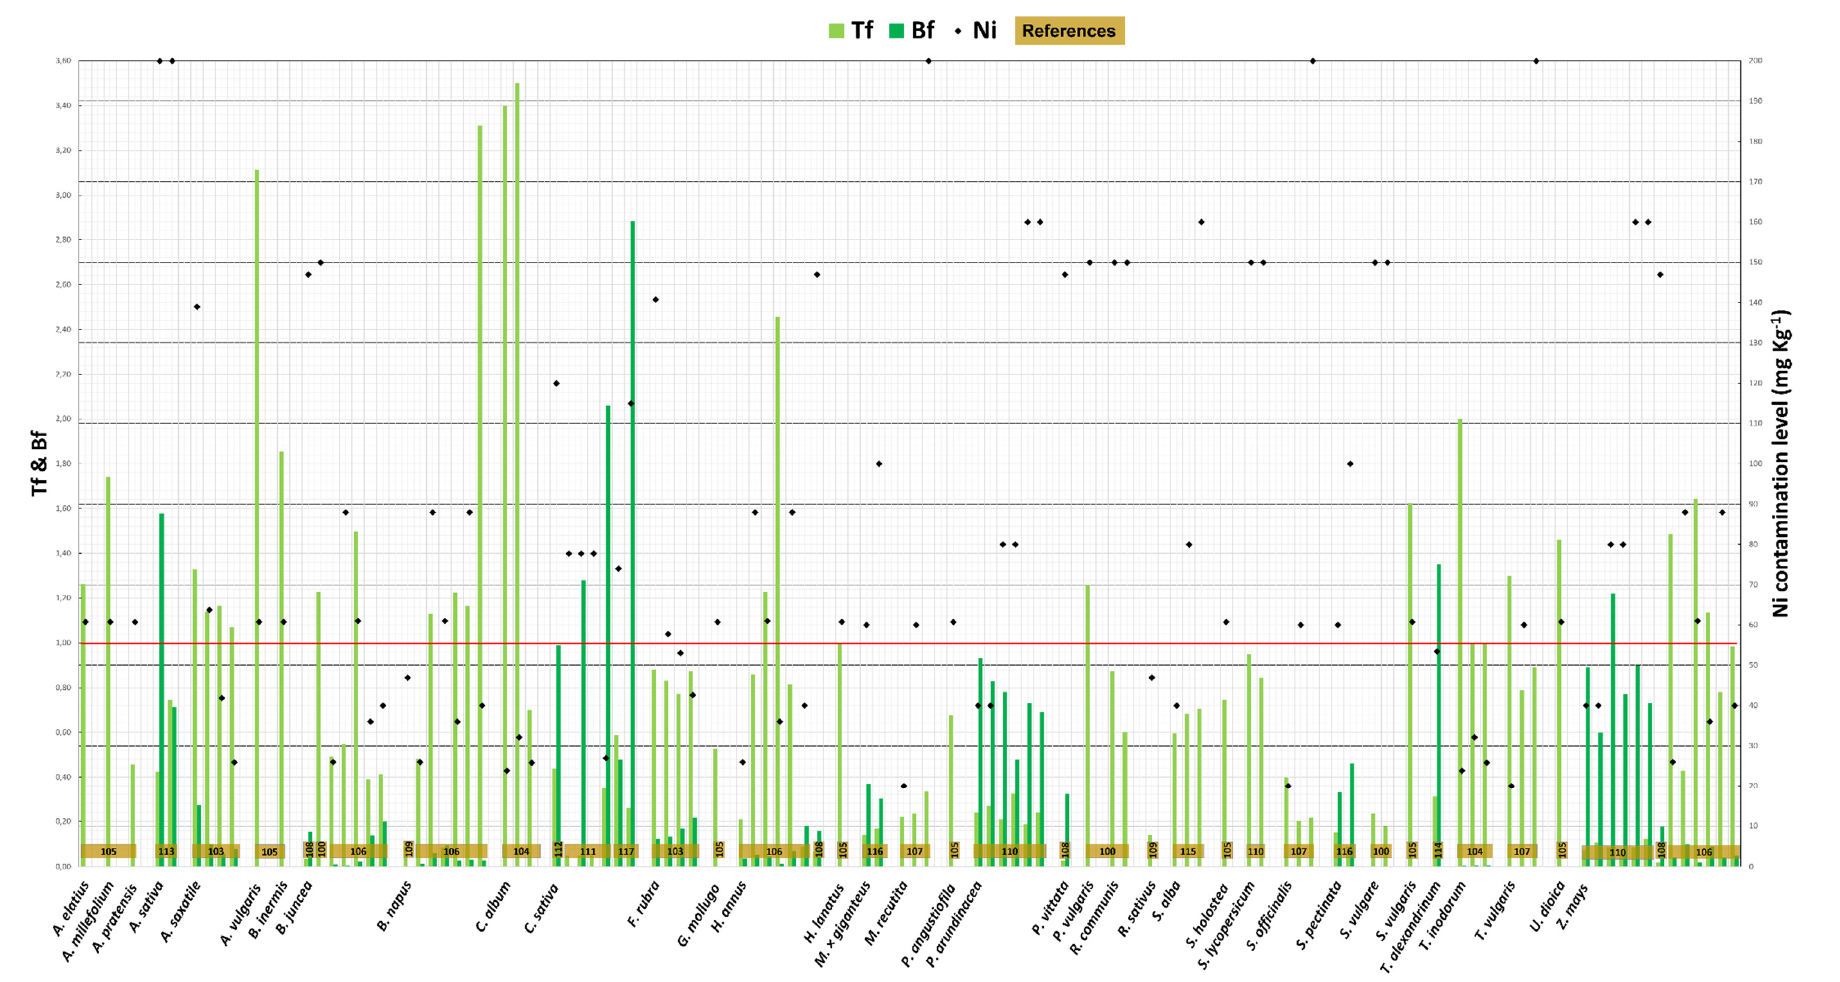
Figure 1. European phytoremediation experiments with Ni at low/moderate contamination. The red line indicates level 1 of the evaluated phytoremediation parameters: Tf (translocation factor, light-green bars) and Bf (bioconcentration factor, dark-green bars). Black diamond points indicate the level of Ni contamination in the substrate studied (secondary vertical axis.